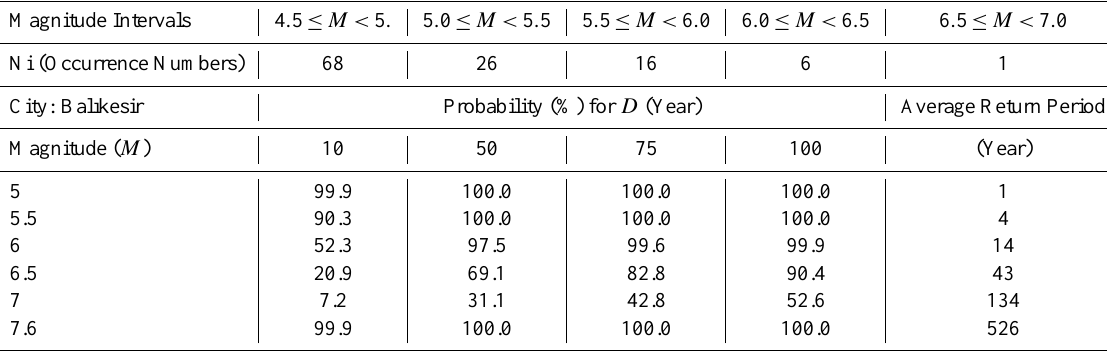
Table 3d. Earthquake occurrence probability (%) for D (Year) for Balıkesir city. Magnitude Intervals